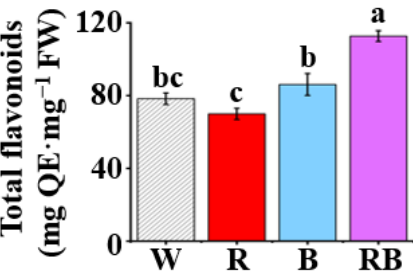
Figure 5. E ff ect of light quality on the content of total flavonoids in leaves of C. triste plantlets after four weeks of culture: The light qualities used were W, white LED; R, red LED; B, blue LED; and RB, combined red and blue LEDs in a 1:1 ratio. The results were expressed as means ± standard errors ( n = 3). Di ff erent letters indicate significant di ff erences ( p < 0.05) by the Tukey’s multiple range test.